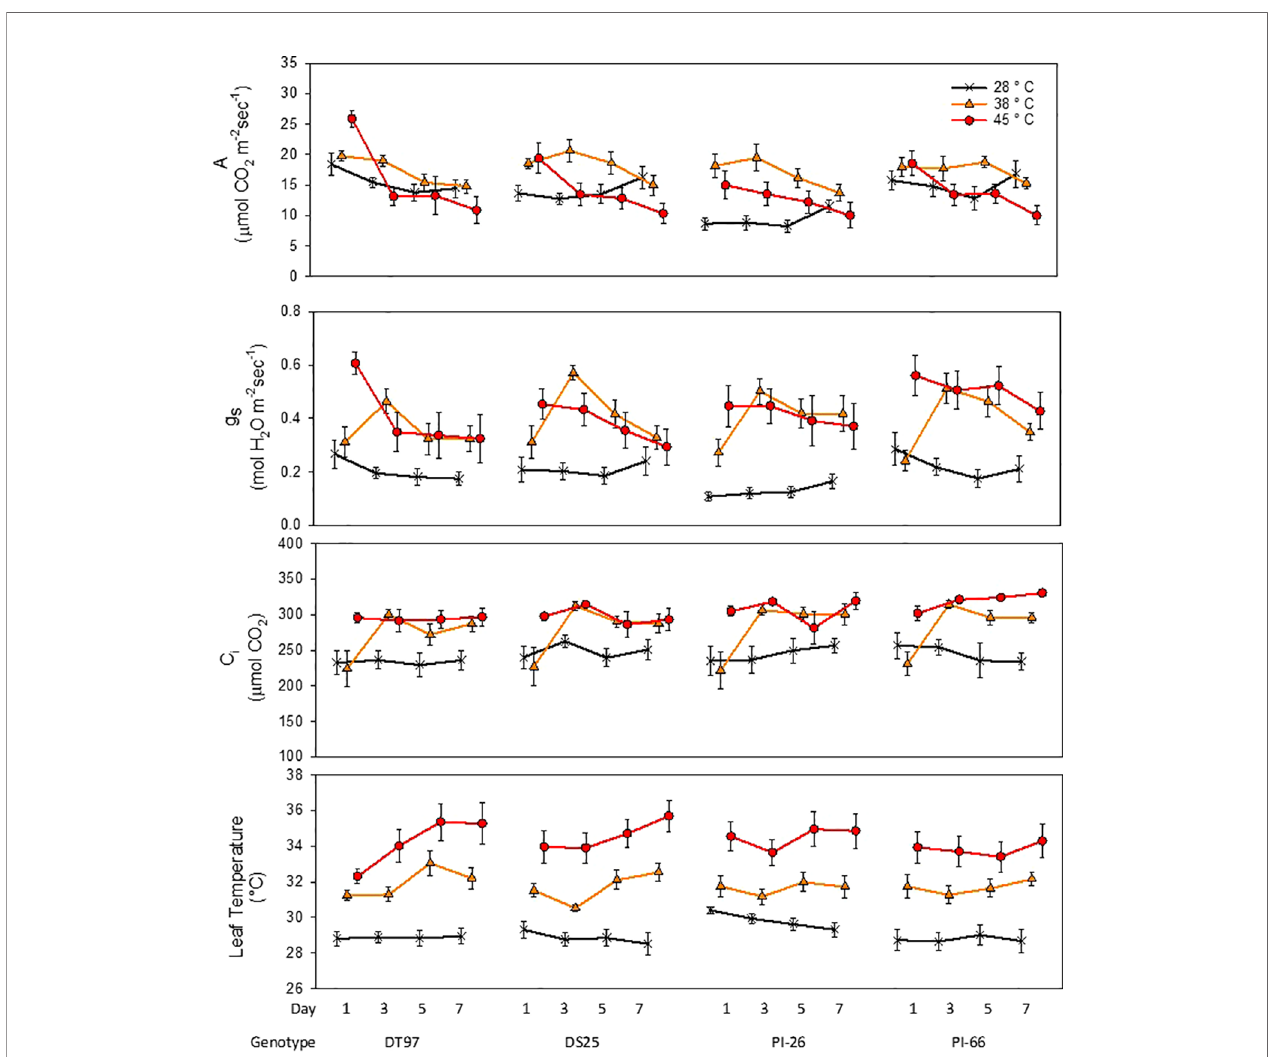
FIGURE 1 | Responses of photosynthetic rate (A), stomatal conductance (g s ), internal CO 2 (C i ), and leaf temperature of four soybean genotypes to the imposition of maximum day time temperatures of 28, 38, and 45°C over the course of 7 days. Measurements were taken from the uppermost middle trifoliate leaves 2 h after air temperatures reached the indicated temperature on days 1, 3, 5, and 7. Symbols represent mean values (N = 12) and whiskers indicate standard